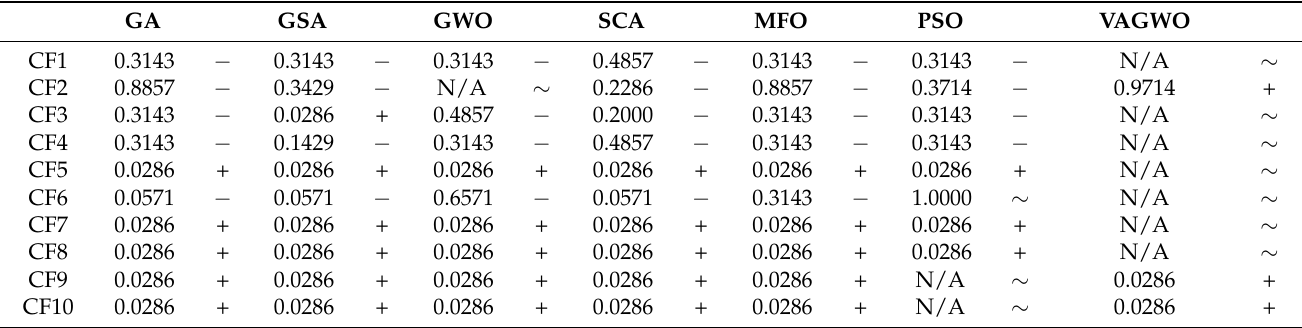
Table 10. p -values and signs of Wilcoxon test for VAGWO against the popular algorithms on the CEC2017 composition